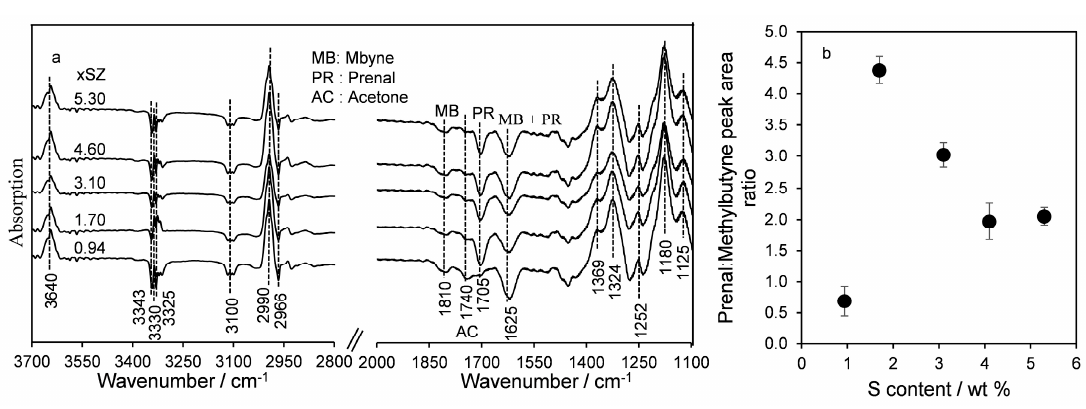
Figure 8. ( a ) IR difference spectra following 1.3 kPa MBOH room temperature MBOH adsorption and subsequent 200 °C heating and cooling, and ( b ) corresponding prenal:methylbutyne peak area as a function of bulk S loading.